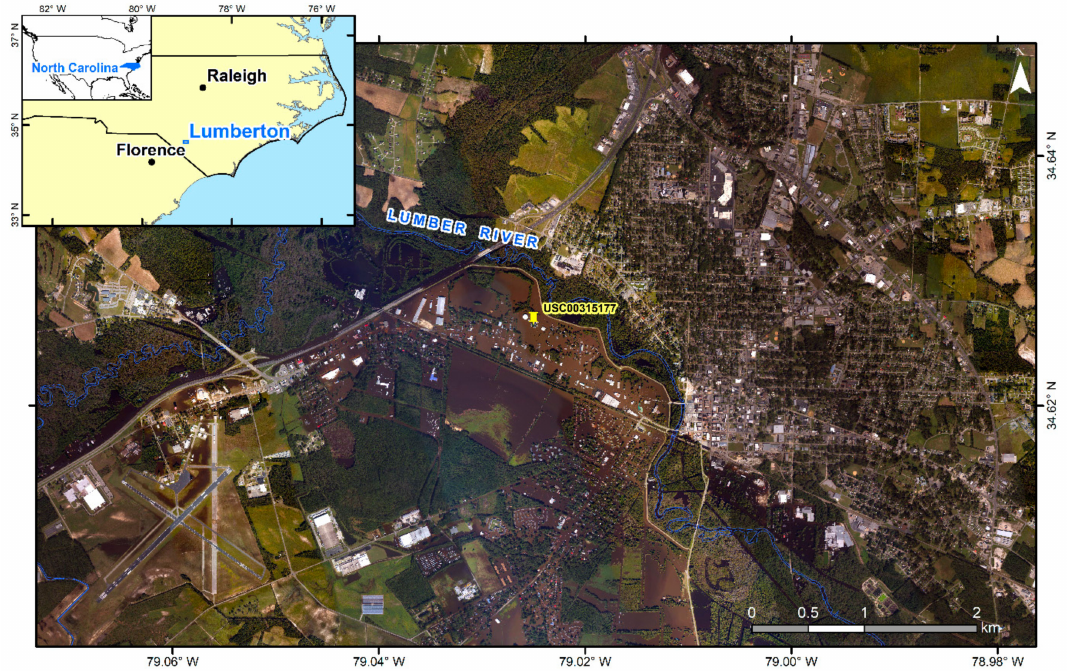
Figure 1. Lumberton in Robeson County, North Carolina, and the during-event airborne optical imagery taken on 11 October 2016. The Lumber River flows right through the middle of the town. USC00315177 is National Oceanic and Atmospheric Administration (NOAA)’s ground weather